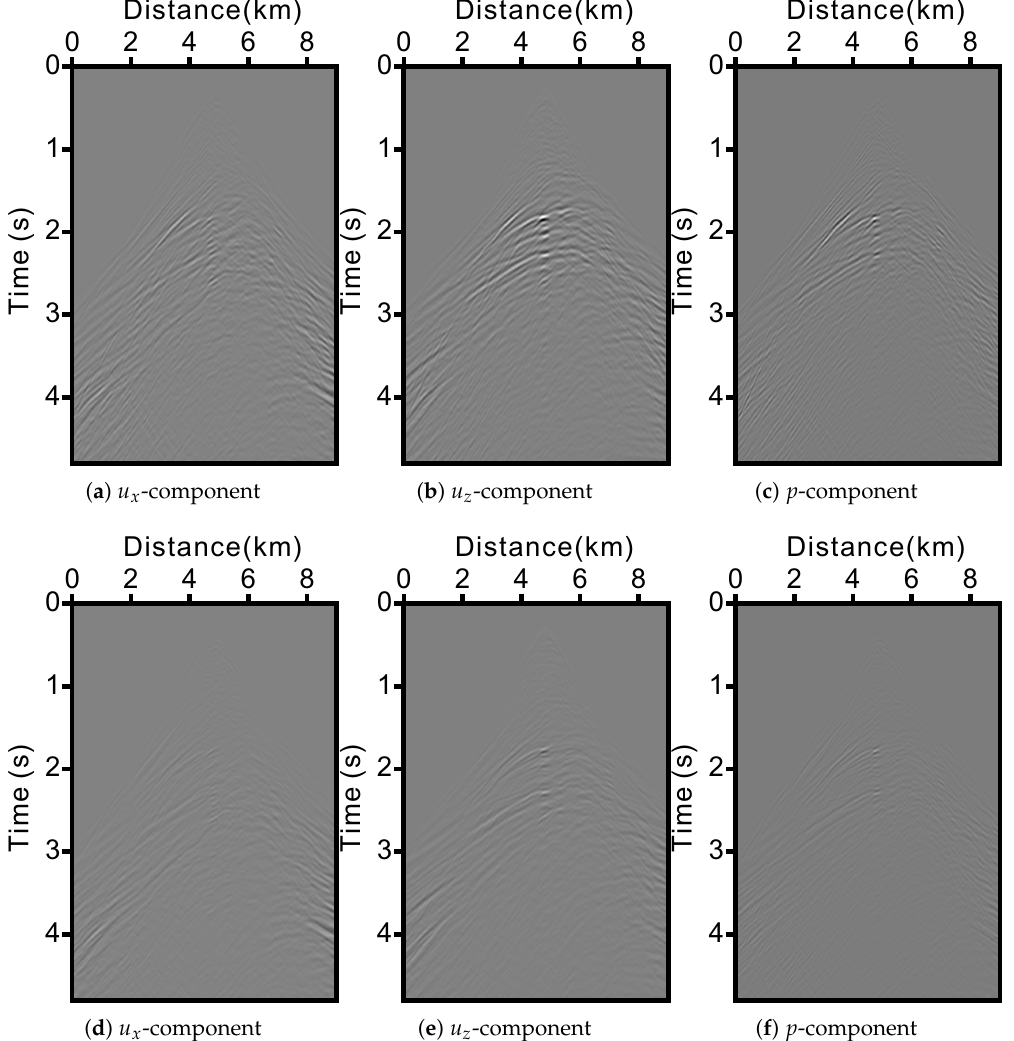
Figure 16. Multicomponent data residuals obtained by inverted models in Figure 13. The scale is consistent with the shot gathers in Figure 12. Panels ( a – c ) denote the residuals of EFWI, and panels ( d – f ) indicate those of AEC-EFWI.